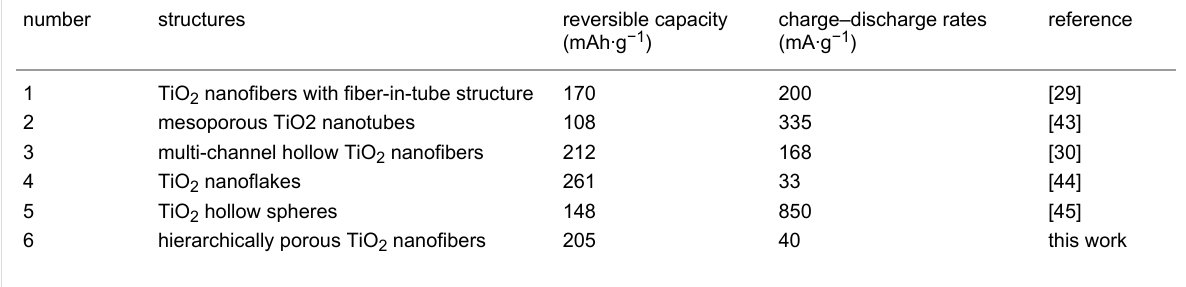
Table 1: Comparison of electrochemical performances of different TiO 2